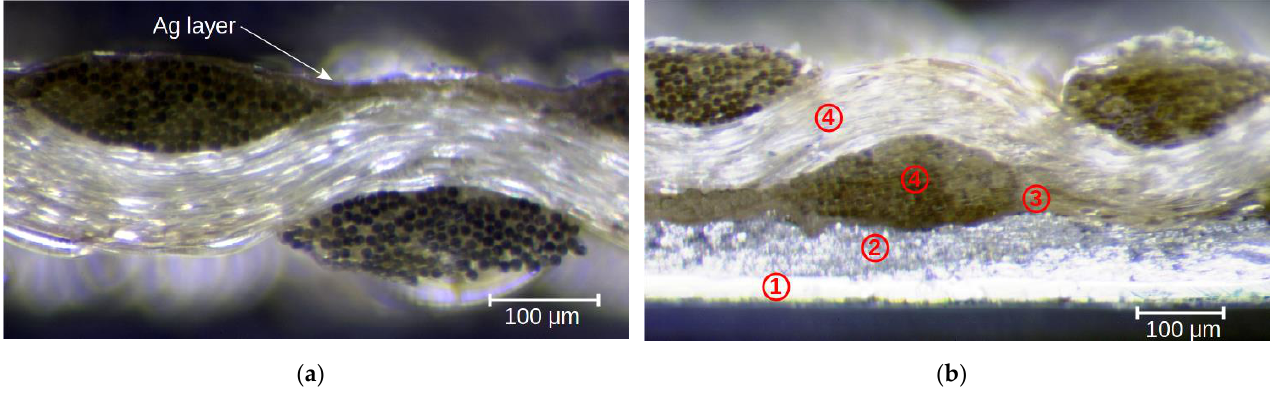
Figure 9. Microscope images of the cross-sections of a silver-coated Cordura textile ( a ) and a glued joint ( b ), where: 1 — silver foil, 2 — electroconductive paste, 3 — polyurethane layer, 4 — nylon threads. At the point of connection with the silver electrode (foil), deformation of the substrate and Ag layer was very limited by the rigid electroconductive paste layer and the strong